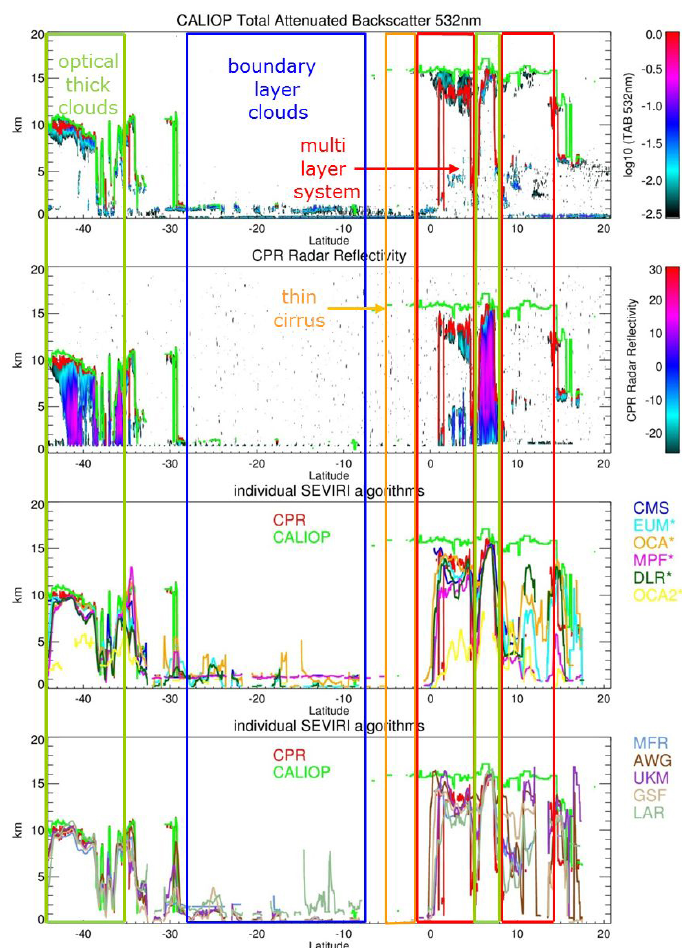
Figure 5. Validation of the SEVIRI cloud top height (CTH) retrievals with CALIOP and CPR for 13 June 2008, 13:45UTC or A-train overpass 11318. In the first and second panel, the CALIOP backscatter profiles and the CPR reflectivity are shown together with the CTH derived from these instruments. In the third and fourth panel the CTHs derived by the ten SEVIRI algorithms are shown. The OCA algorithm additionally derives the CTH of a possible second cloud layer; this product is labeled as OCA2. Stars at the algorithm name indicate that these algorithms submitted CTP being converted to CTH. The colored boxes roughly indicate different cloud regimes being discussed in more detail in Sect.